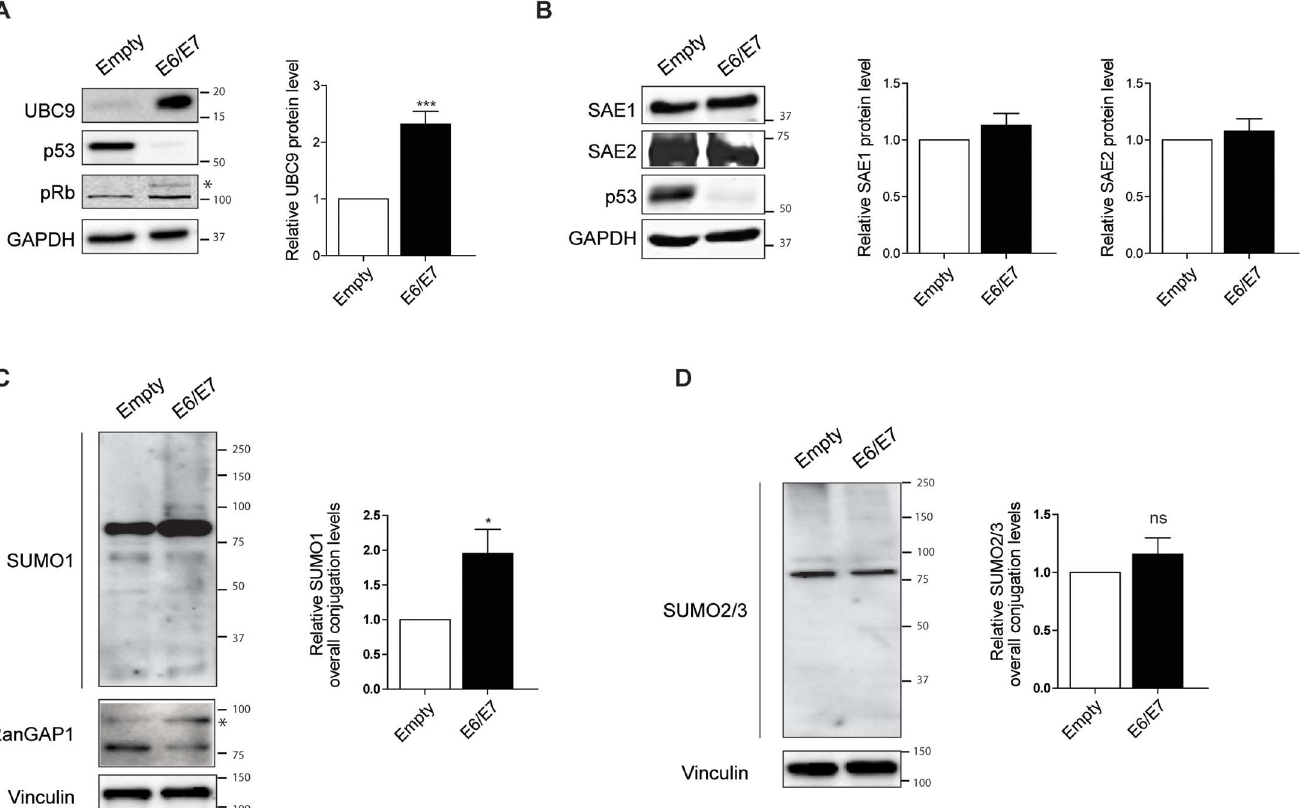
Fig 2. HPV16 E6/E7 selectively up-regulate UBC9 and SUMO1 conjugation. (A) and (B) Left: Representative WBs of HKs transduced with empty or HPV16 E6/E7 recombinant retroviral vectors. Successful E6/E7 infectionswere confirmedby p53 degradationand pRb inactivation. Asterisk marks the phosphorylated form of pRb. Right: Normalizedprotein bandsintensities.Data are expressed as fold over the empty-transduced HKs. Bars represent means ± SEM of n = 8. *** P < 0.0001 (paired-sample t-test). (C) and (D) Left: Representative WBs of HKs transducedwith empty or HPV16 E6/E7 recombinantretroviral vectors, and blotted with antibodiesagainst SUMO1, RanGAP1, and SUMO2/3, respectively.Asterisk marks SUMO1-modified RanGAP1. Right: NormalizedSUMO1 and SUMO2/3 smear bands intensities, quantifiedas describedin [91]. Data are expressedas fold over the empty-transduced HKs. Bars represent means ± SEM of n = 9. * P < 0.05(paired-sample